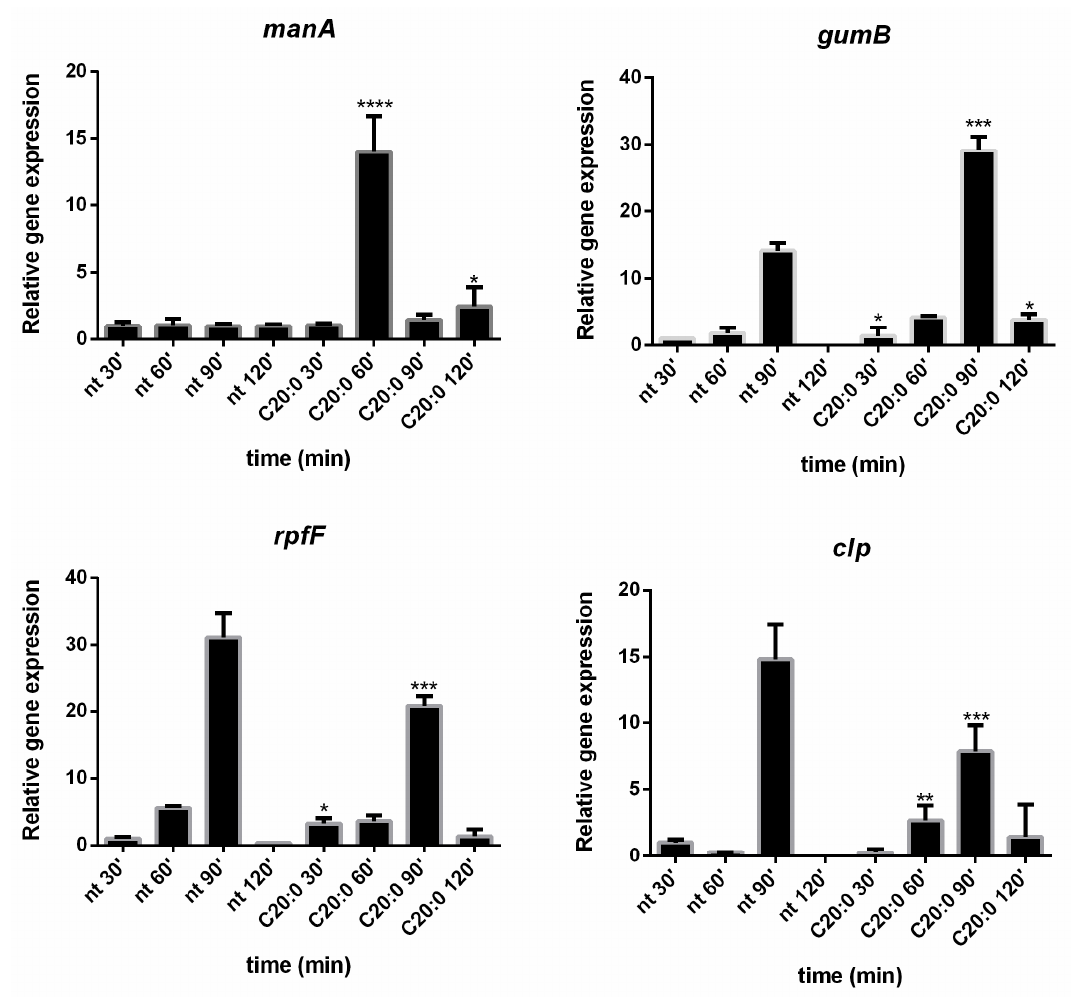
Figure 6. Expression profiling of Xcc genes by quantitative real-time PCR (qPCR) of the different genes involved in biofilm formation and quorum sensing. Biofilm samples were collected at different durations of treatment with C20:0. Statistical analysis was performed with the relative gene expression compared to the untreated control and considered statistically significant when p < 0.05 (* p < 0.05, ** p < 0.01, *** p < 0.001, **** p < 0.0001) according to two-way ANOVA multiple comparisons.